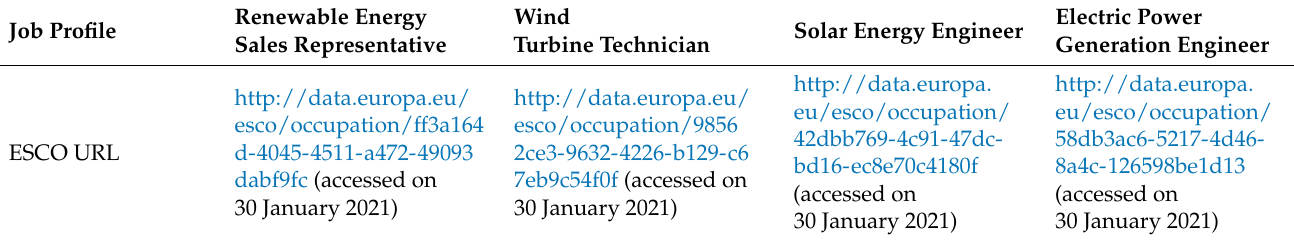
Table 6. Preview of some tabs from the generated database of job profiles from the renewable energy sector. Job